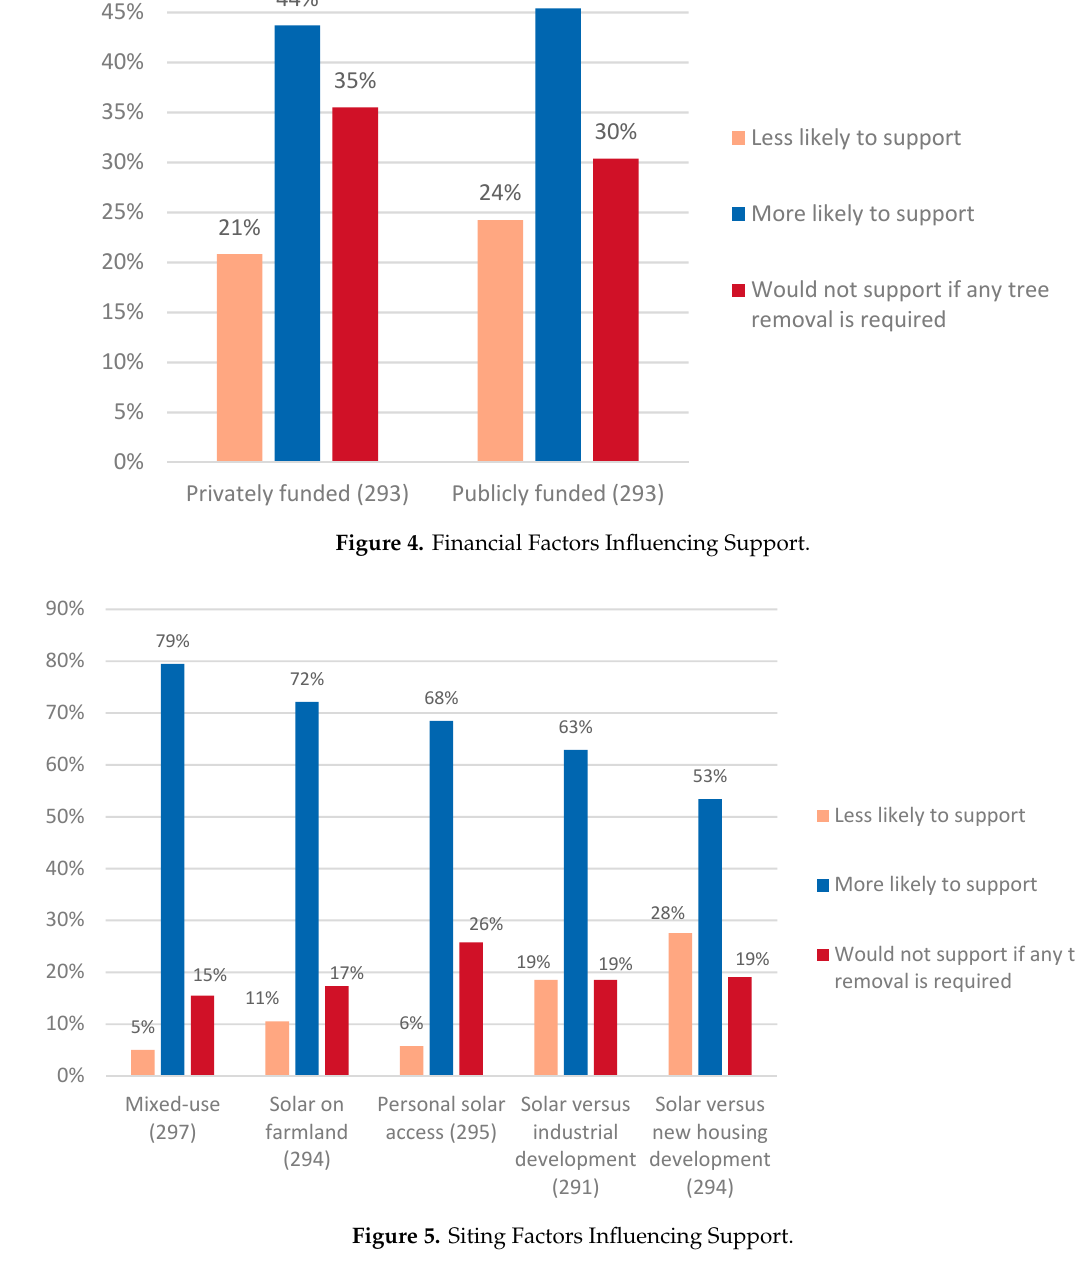
Figure 5. Siting Factors Influencing Support.